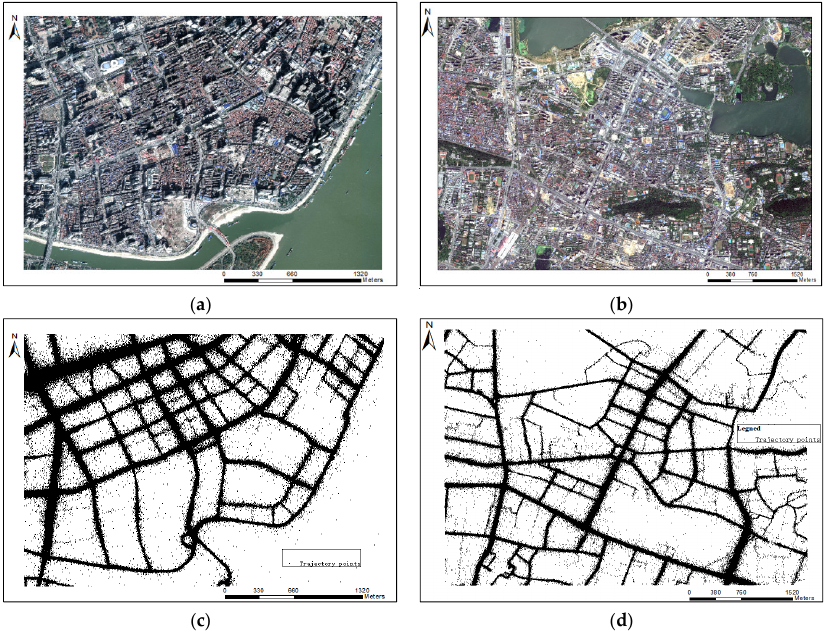
Figure 8. Trajectory datasets: ( a ) remote sensing image for Wuhan1 in Hankou District; ( b ) remote sensing image for Wuhan2 in Hongshan District; ( c ) trajectory dataset for Wuhan1 in Hankou District; ( d ) trajectory dataset for Wuhan2 in Hongshan District. Table 1. Statistics of these two data sets.